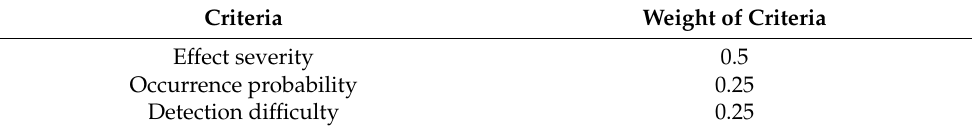
Table 9. The decision matrix for identifying the most critical failure mode.